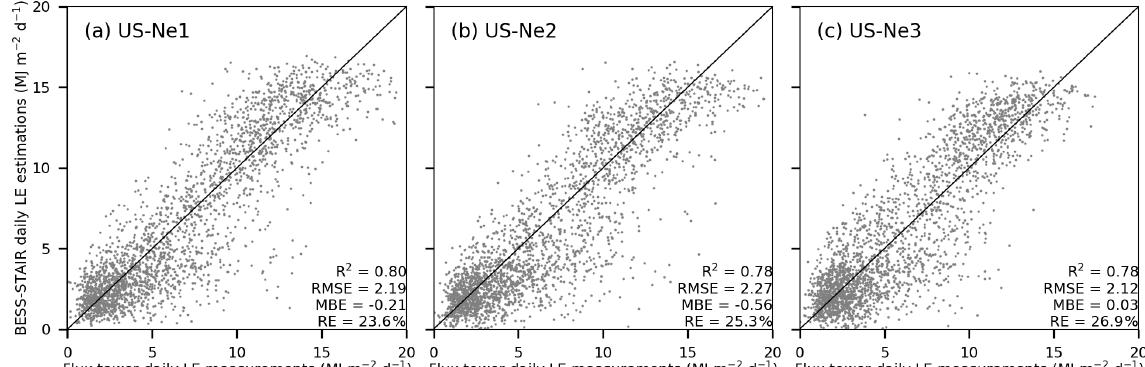
Figure 11. Scatter plots between ET measurements and ET estimations at three sites: US-Ne1, US-Ne2, and